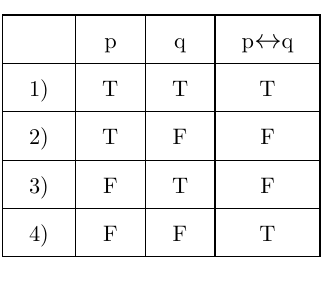
Table 5: Truth-table of equivalent Graph 5: Truth-graph of equivalent expression expression